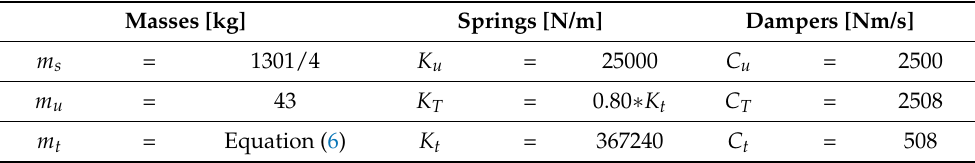
Table 1. Vehicle model parameters.